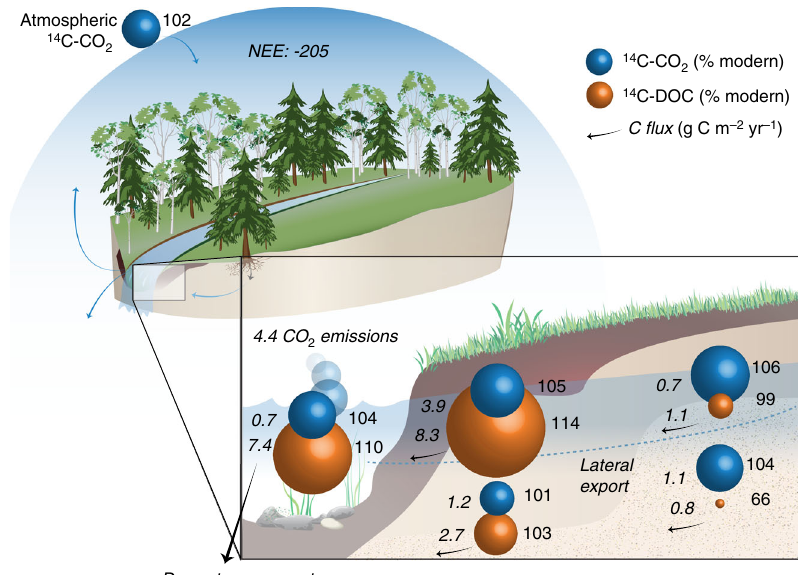
Fig. 5 Schematic of the annual catchment C budget for the studied year. This schematic (unscaled) includes the forest NEE and the lateral and downstream CO 2 and DOC export and stream CO 2 emissions, along with their cumulative annual 14 C contents represented by the sizes of the spheres (blue ( 14 C-CO 2 ) and orange ( 14 C-DOC)), at the three locations along the Upslope-Riparian-Stream transect, and depth (shallow [0 – 0.5 m] and deep [0.5 – 1 m]). Annual C export rates (g C m − 2 yr − 1 ) are written in italic on the left side of each sphere, while the 14 C contents are written on the right